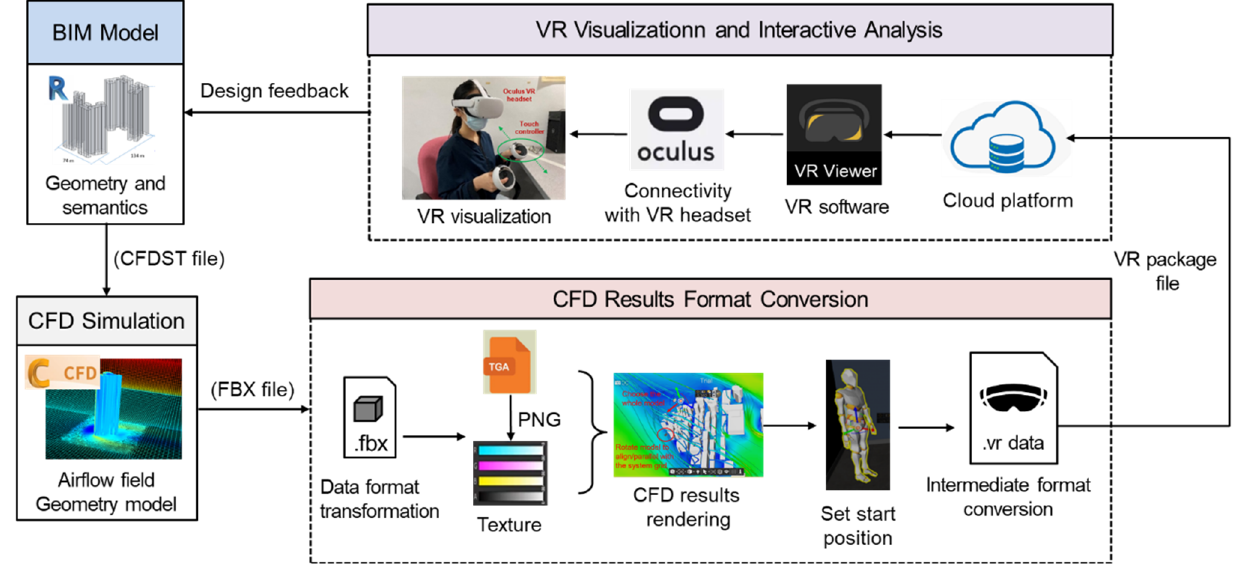
Figure 6. Integrating CFD simulation results with BIM and VR.